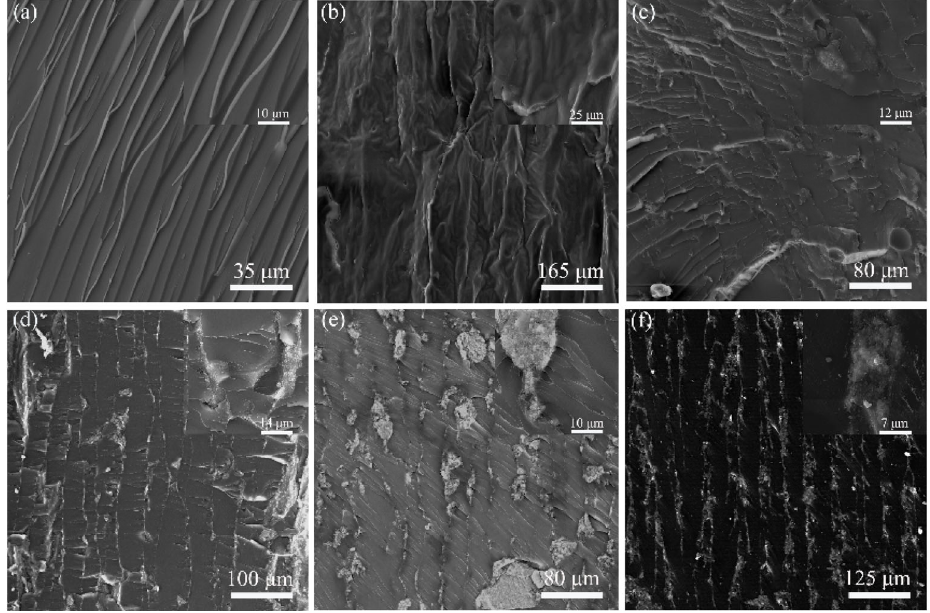
Fig. 4 SEM images of the fracture surfaces of (a) epoxy resin and epoxy–Ti 3 C 2 3DNS composites with (b) 0 g, (c) 0.5 g, (d) 1.0 g, (e) 2.0 g, and (f) 3.0 g few-layer Ti 3 C 2 MXene